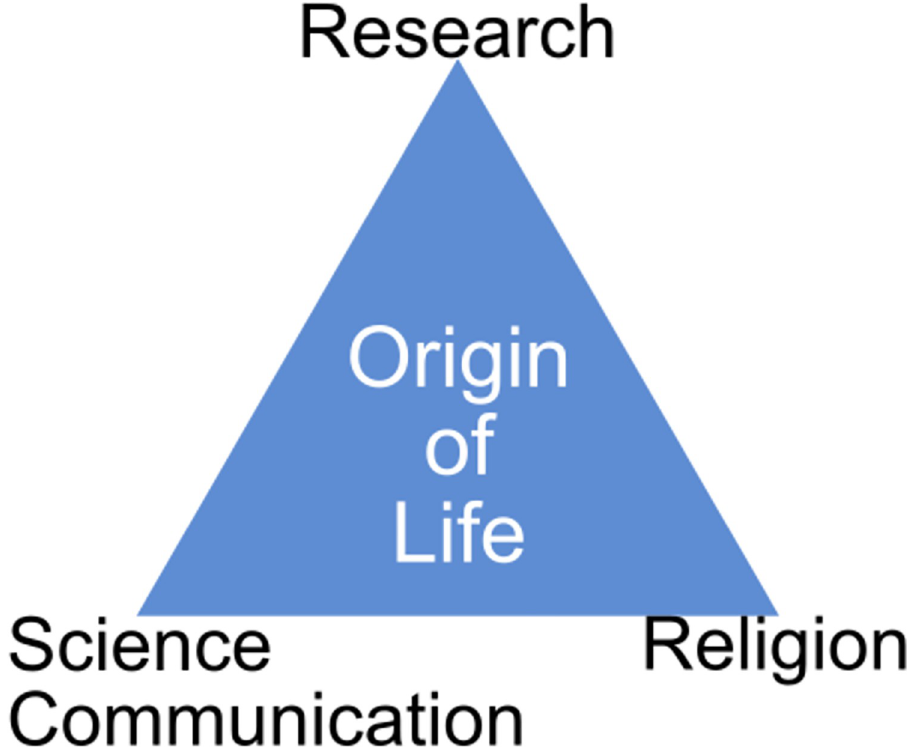
Fig 1. The triangle of mutual social dependencies between OoL research, science communication, and religion. These three aspects contribute to connect OoL to society and relate to each other. In this work we address how scientists approach these topics and their mutual